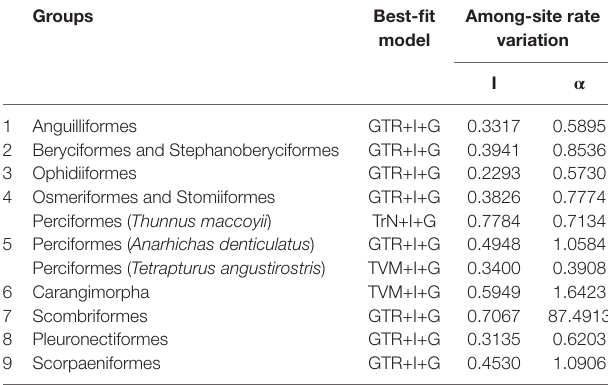
TABlE 1 | Best-fit models for nine deep-sea groups used for phylogenetic